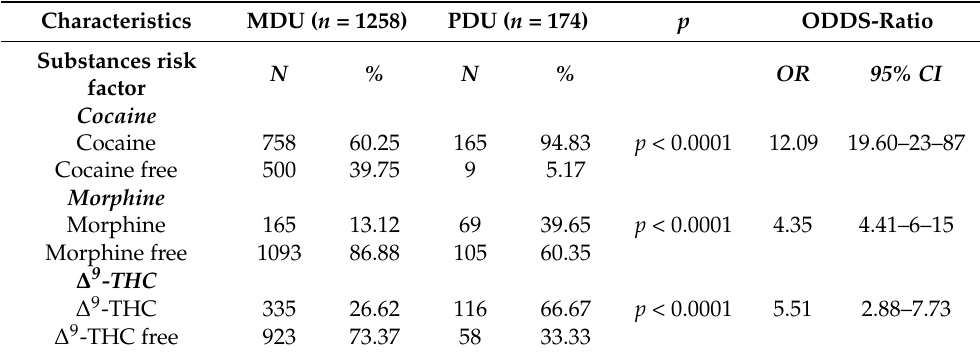
Table 2. Drug of abuse likelihood risk of monodrug users’ group (MDU) and polydrug users’ group